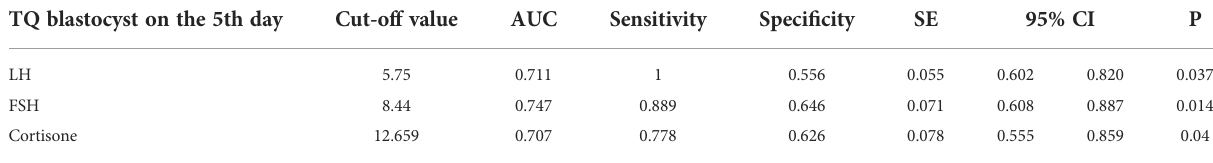
TABLE 3 Receiver operating characteristic curve analysis of LH, FSH and Cortisone levels in FF for top quality blastocysts on the 5th day from 136 matched embryos. TQ blastocyst on the 5th day